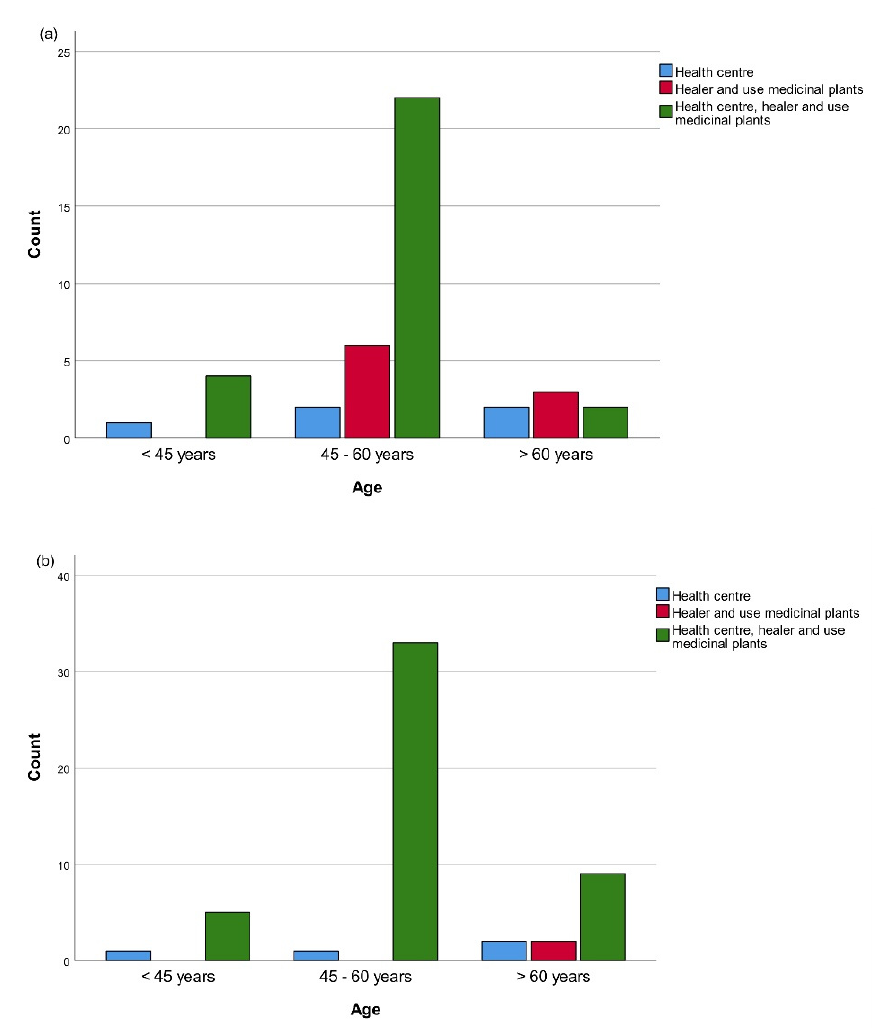
Figure 3. Places where respondents of Quinua ( a ) and Acos Vinchos ( b ) go when they become sick, according to age groups.